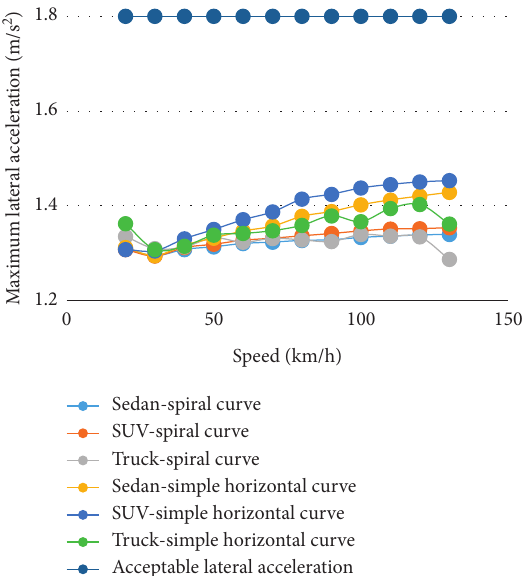
Figure 11: Maximum lateral acceleration in the simple and spiral horizontal curves versus the speed at radius R .